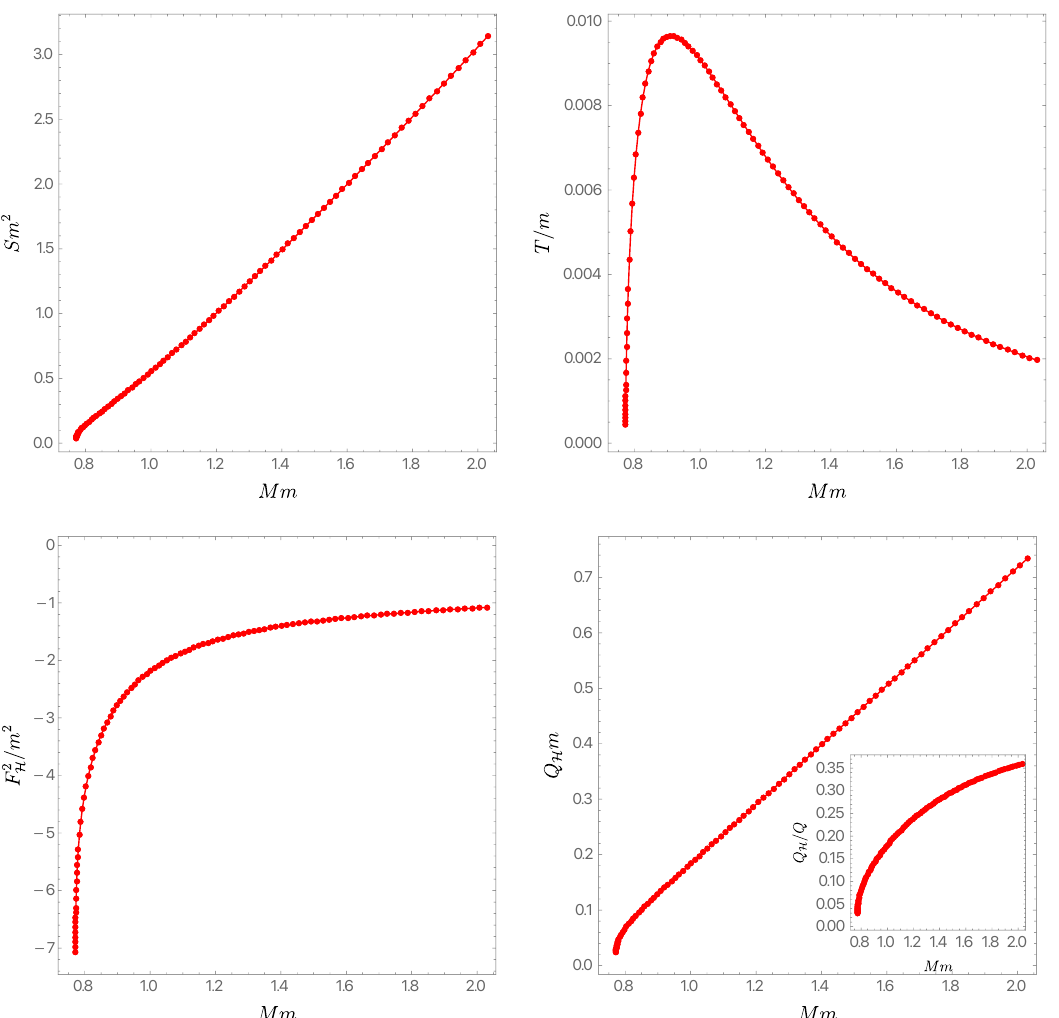
Figure 2 . Physical properties of the maximal warm holes along the red line in figure 1. The plots show the entropy S , temperature T , F 2 on the horizon, and charge on the black hole, Q H , as a function of black hole mass. Note that despite having the maximum charge for a given mass, these black holes have nonzero Hawking temperature! The implications for Hawking evaporation are discussed in section 4.1. In the inset plot of the bottom-right panel we display the ratio Q H /Q between the electric charge on the horizon Q H and the charge Q measured at